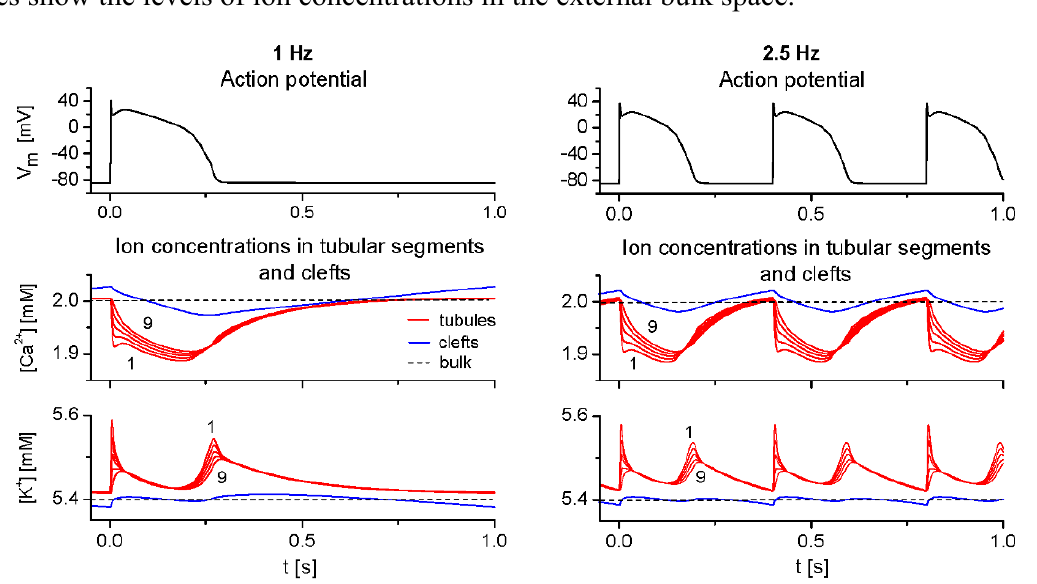
Figure 2. Action potentials ( V ) and ion concentrations ([Ca 2+ ], [K + ]) in the first, third, m fifth, seventh and ninth segments of tubular lumen (red lines) and in cleft space (blue lines) at 1 Hz ( left panel ) and 2.5 Hz ( right panel ) steady-state stimulation. Horizontal dashed lines show the levels of ion concentrations in the external bulk